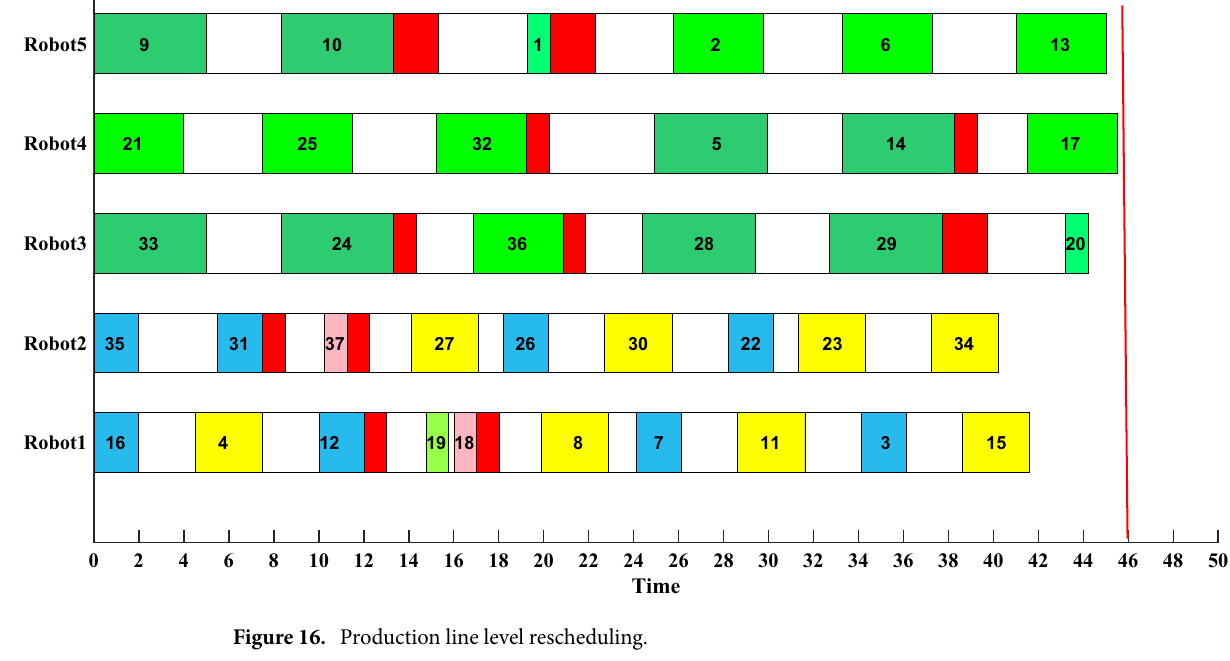
Figure 16. Production line level